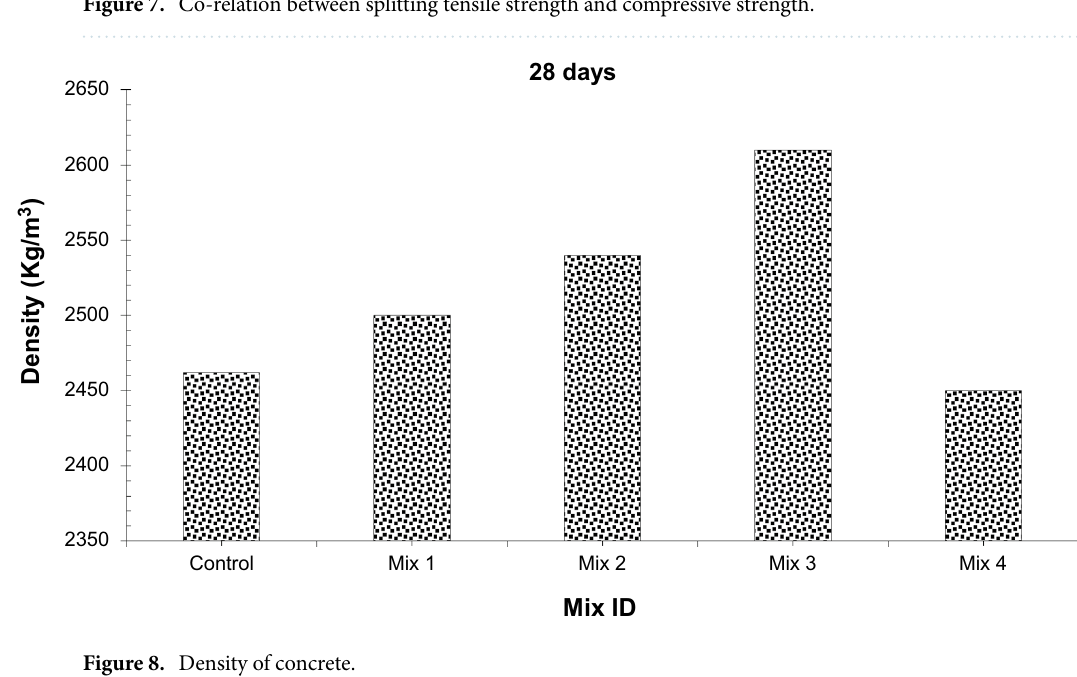
Figure 8. Density of